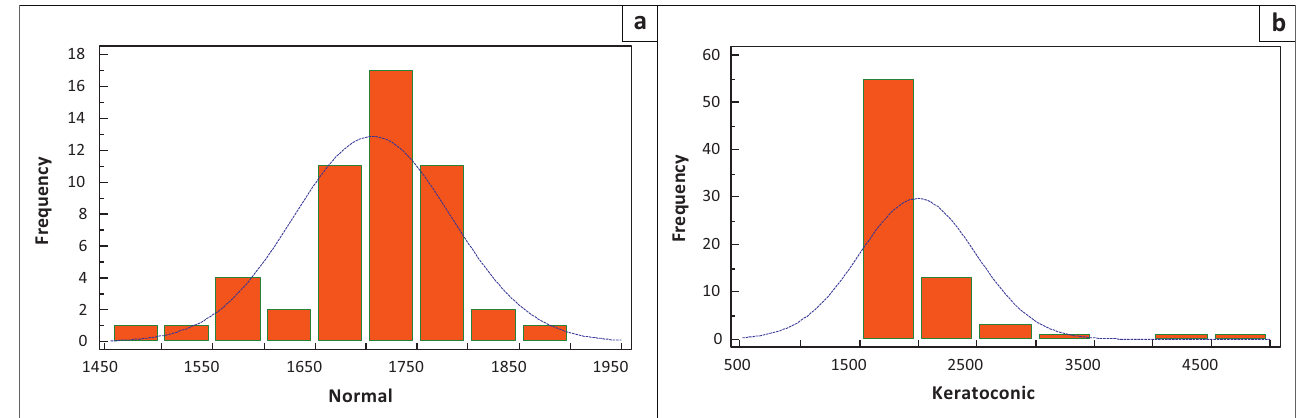
FIGURE 2: Frequency distribution histograms, with normal distribution curve (blue dotted curve) included, are shown. (a) Normal corneas, (b) keratoconic corneas.